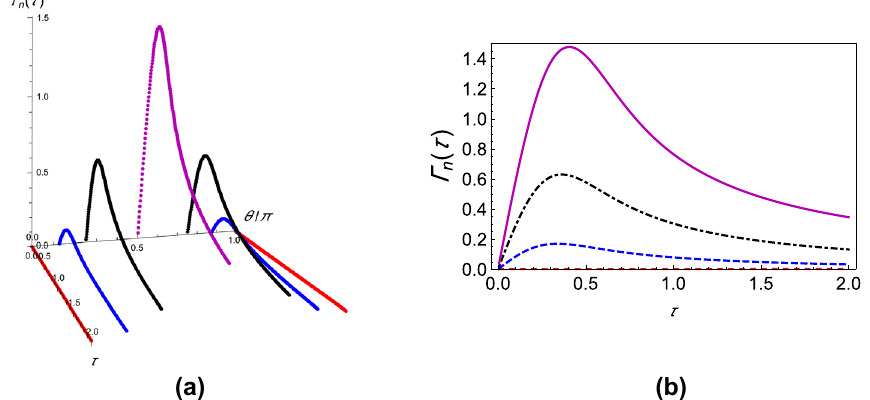
Figure 5. Variation of the modified decay rates with the initial state of the two-level system. ( a ) The effective modified decay rate Ŵ n (τ) as a function of τ for different initial states. ( b ) Here we show Ŵ n (τ) sections of ( a ). The parameters used in ( a ) and ( b ) are the same as Fig. 2, except that we are now plotting the modified decay rates against the measurement interval.